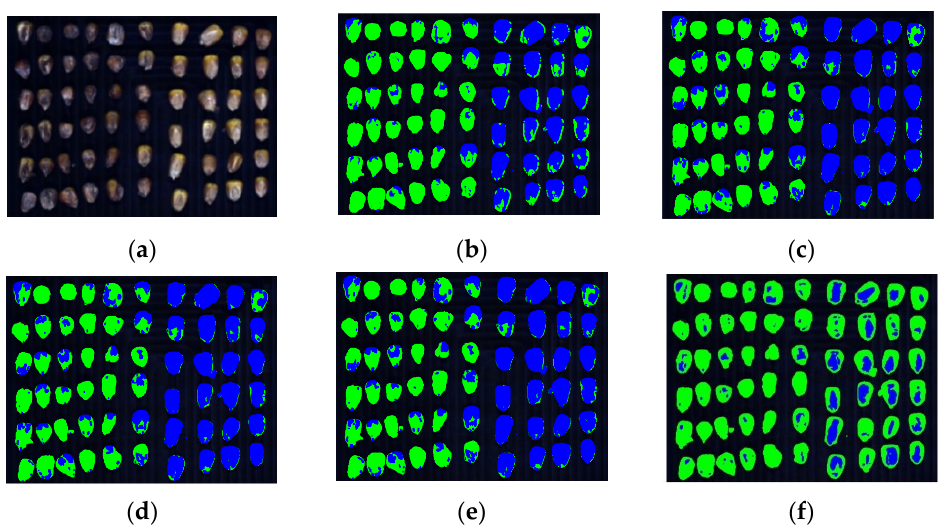
Figure 11. Clustering results in corn kernel mildew hyperspectral image data by different algorithms (spectral and image features). ( a ), Mildew corn kernels; ( b ), K-means; ( c ), FCM; ( d ), KFCM; ( e ), GMM; ( f ), FCM-SC.